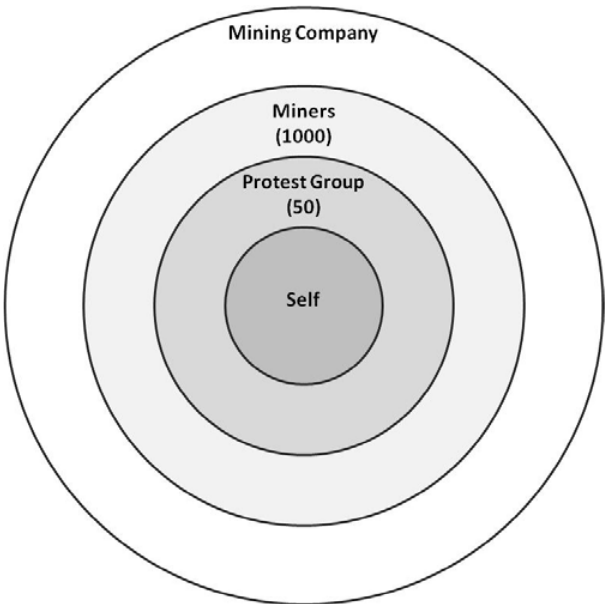
Figure 2. Layers of Group Identity in the